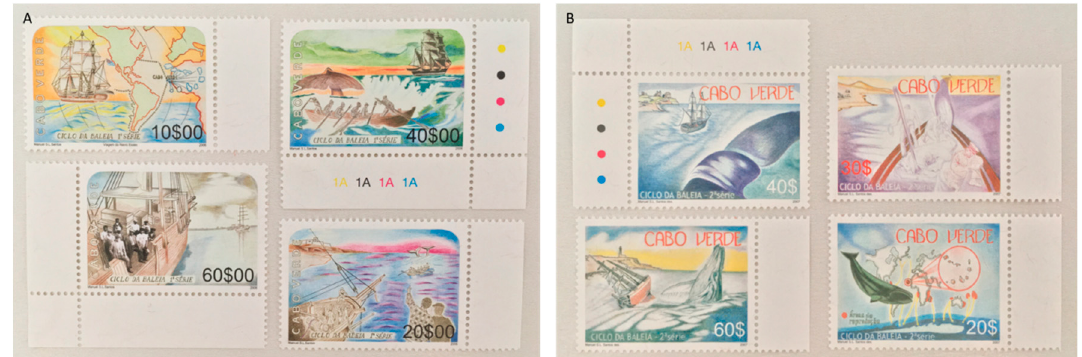
Figure 10. ( A ) Stamps of the 1st series collection Ciclo da Baleia (Cycle of the Whale) produced in 2006 and ( B ) Stamps of the 2nd series of the same collection produced in 2007 by the Post Office of Cape Verde, with representation of whale species and whaling scenes.